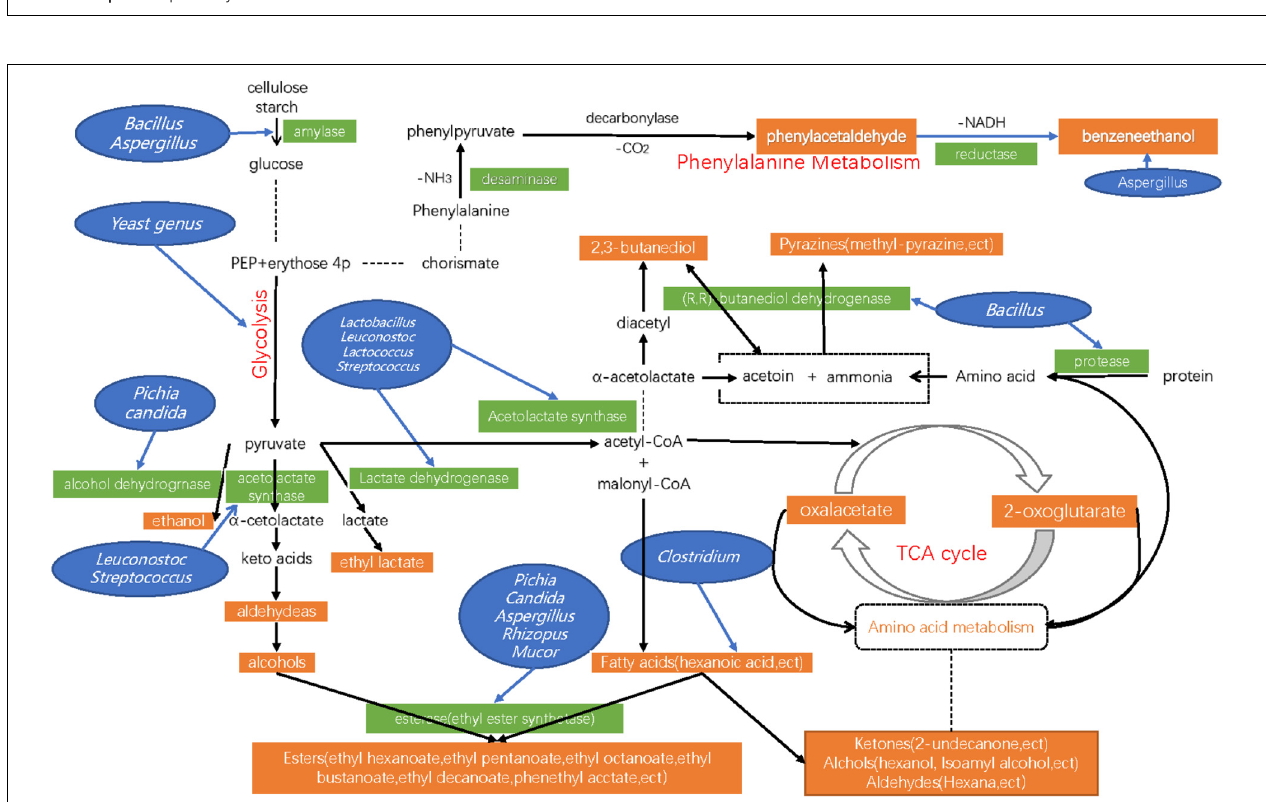
FIGURE 8 | Schematic presentation of pathways, metabolites, enzymes, and genus related to the synthesis of Ethanol, Phenylethanol, Phenylacetaldehyde, and Lactic acids, ect in Daqu samples. The pathways were organized based on the KEGG (Kyoto Encyclopedia of Genes and Genomes).